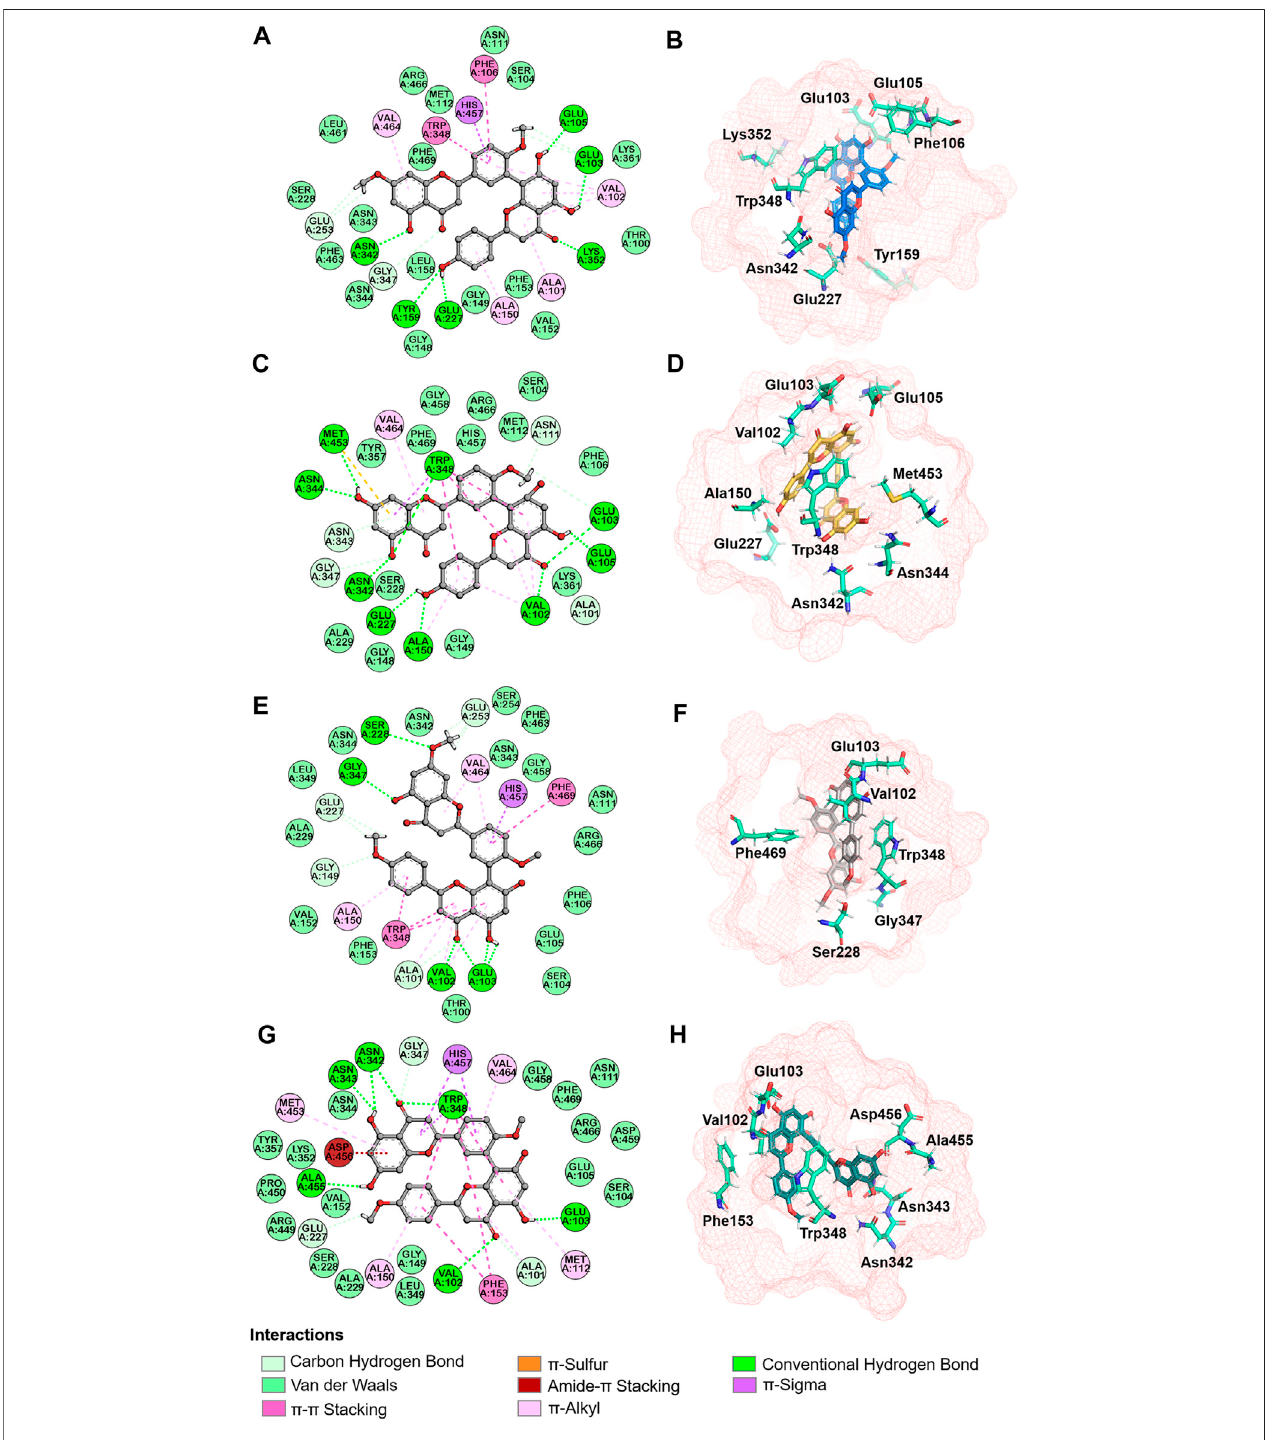
FIGURE 11 | Interaction analysis and spatial arrangement with ginkgetin (A,B) , bilobetin (C,D) , sciadopitysin (E,F) , isoginkgetin (G,H) were proposed in 2D (left) and 3D (right) diagrams. Active site and pivotal residues were exhibited in red mesh and cyan sticks in stereo view.